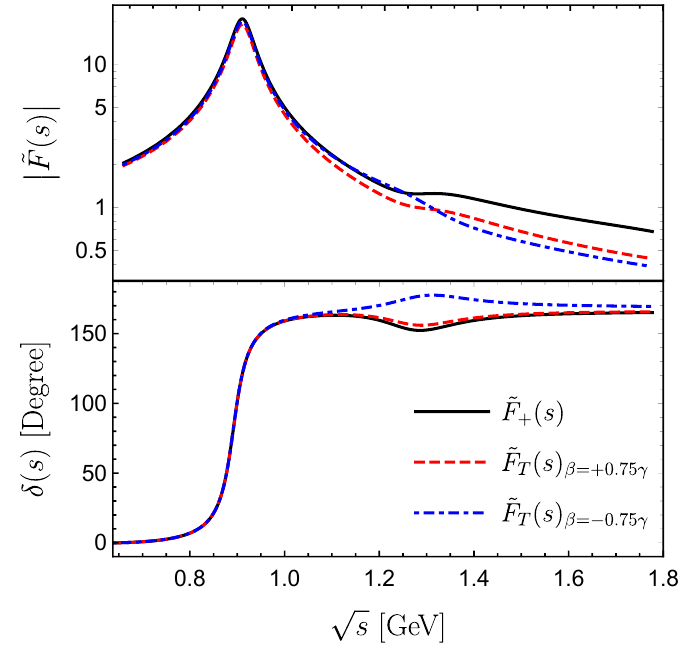
Figure 6 . Moduli and phases of the normalized Kπ vector ( ˜ F + ( s ) ) and tensor ( ˜ F T ( s ) ) form factors. The explicit expression of the vector form factor (black solid curves) is taken from refs. [45, 46], while that of the tensor form factor from ref. [34], with the red dashed and blue dot-dashed curves corresponding to the cases β = +0 . 75 γ and β = − 0 . 75 γ ,